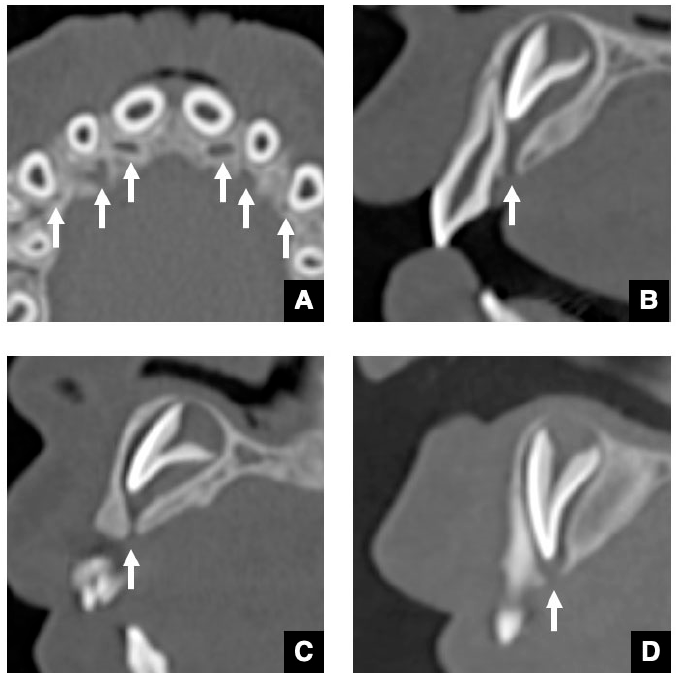
Figure 1. CBCT images of various periods of GTs in maxillary central incisors with normal eruption as representative successional teeth. ( A ) The GTs in anterior teeth (arrows) appear as six round-shaped areas with low density on the palatal side of the deciduous predecessor on an axial CBCT image. ( B ) The GT (arrow) was viewed as a low-density corticated tract contiguous with the dental follicle of an unerupted maxillary central incisor on a sagittal image. ( C ) The GT (arrow) becomes shorter as the unerupted central incisor erupts in the alveolar crest on a sagittal image. ( D ) The GT disappears (arrow) when the DS of the unerupted central incisor becomes contiguous to the alveolar crest on a sagittal image.